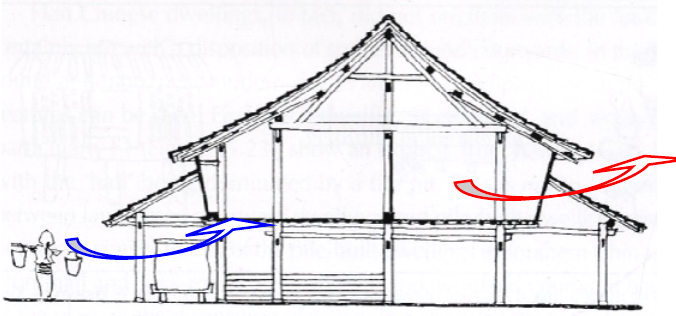
Figure 22. After wooden storied house section, [17].